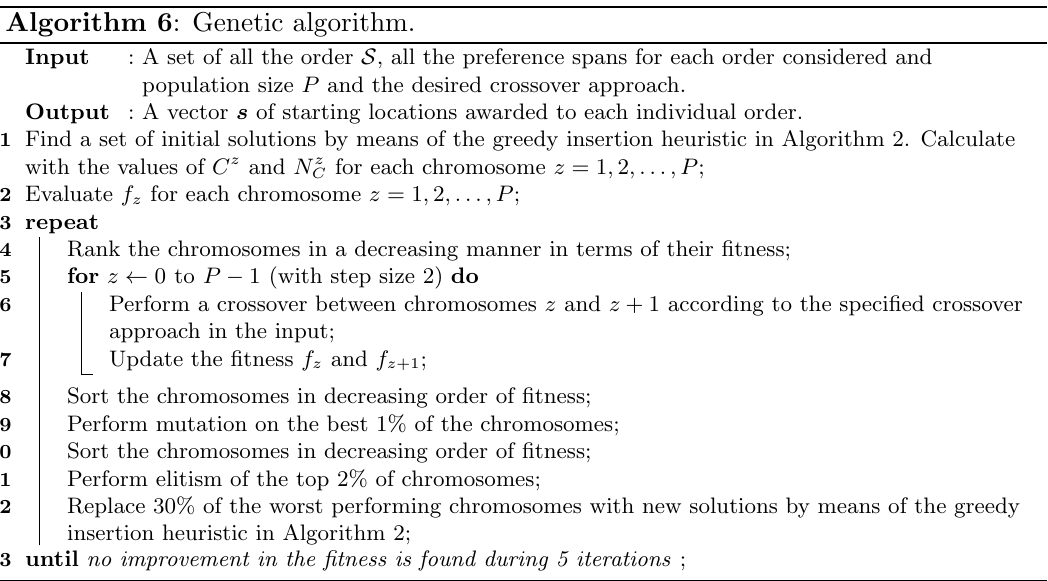
Algorithm 6 : Genetic